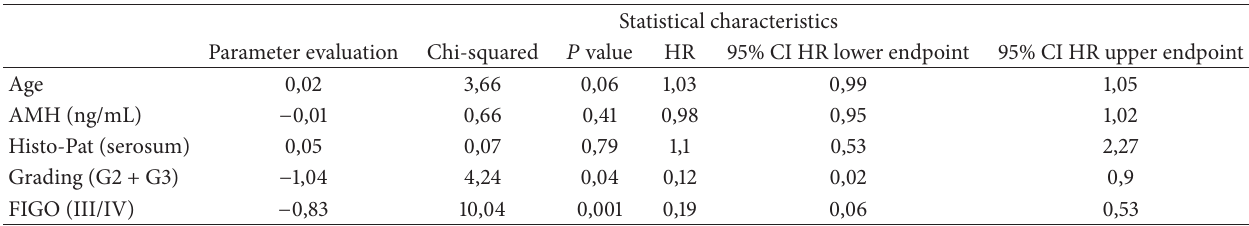
Table 5: Prognostic factors for overall survival selected by Cox’s univariate analysis.